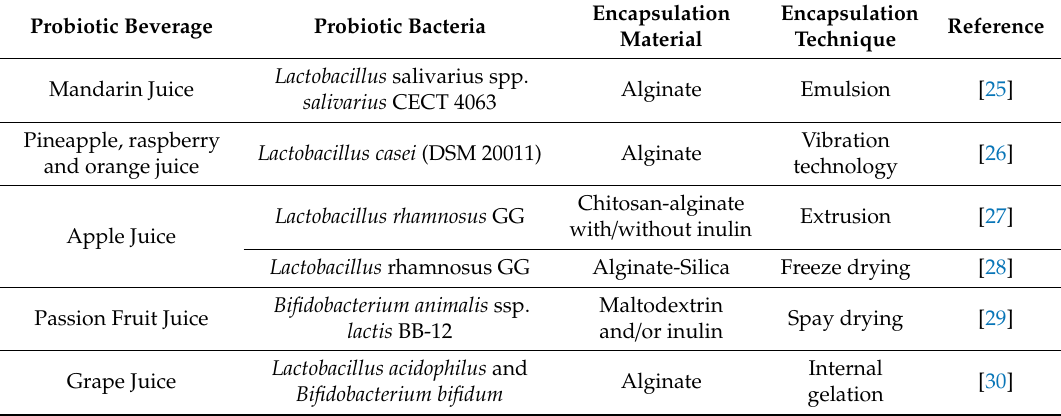
Table 2. Applications of encapsulation technologies on probiotic bacteria used for non-dairy beverages.